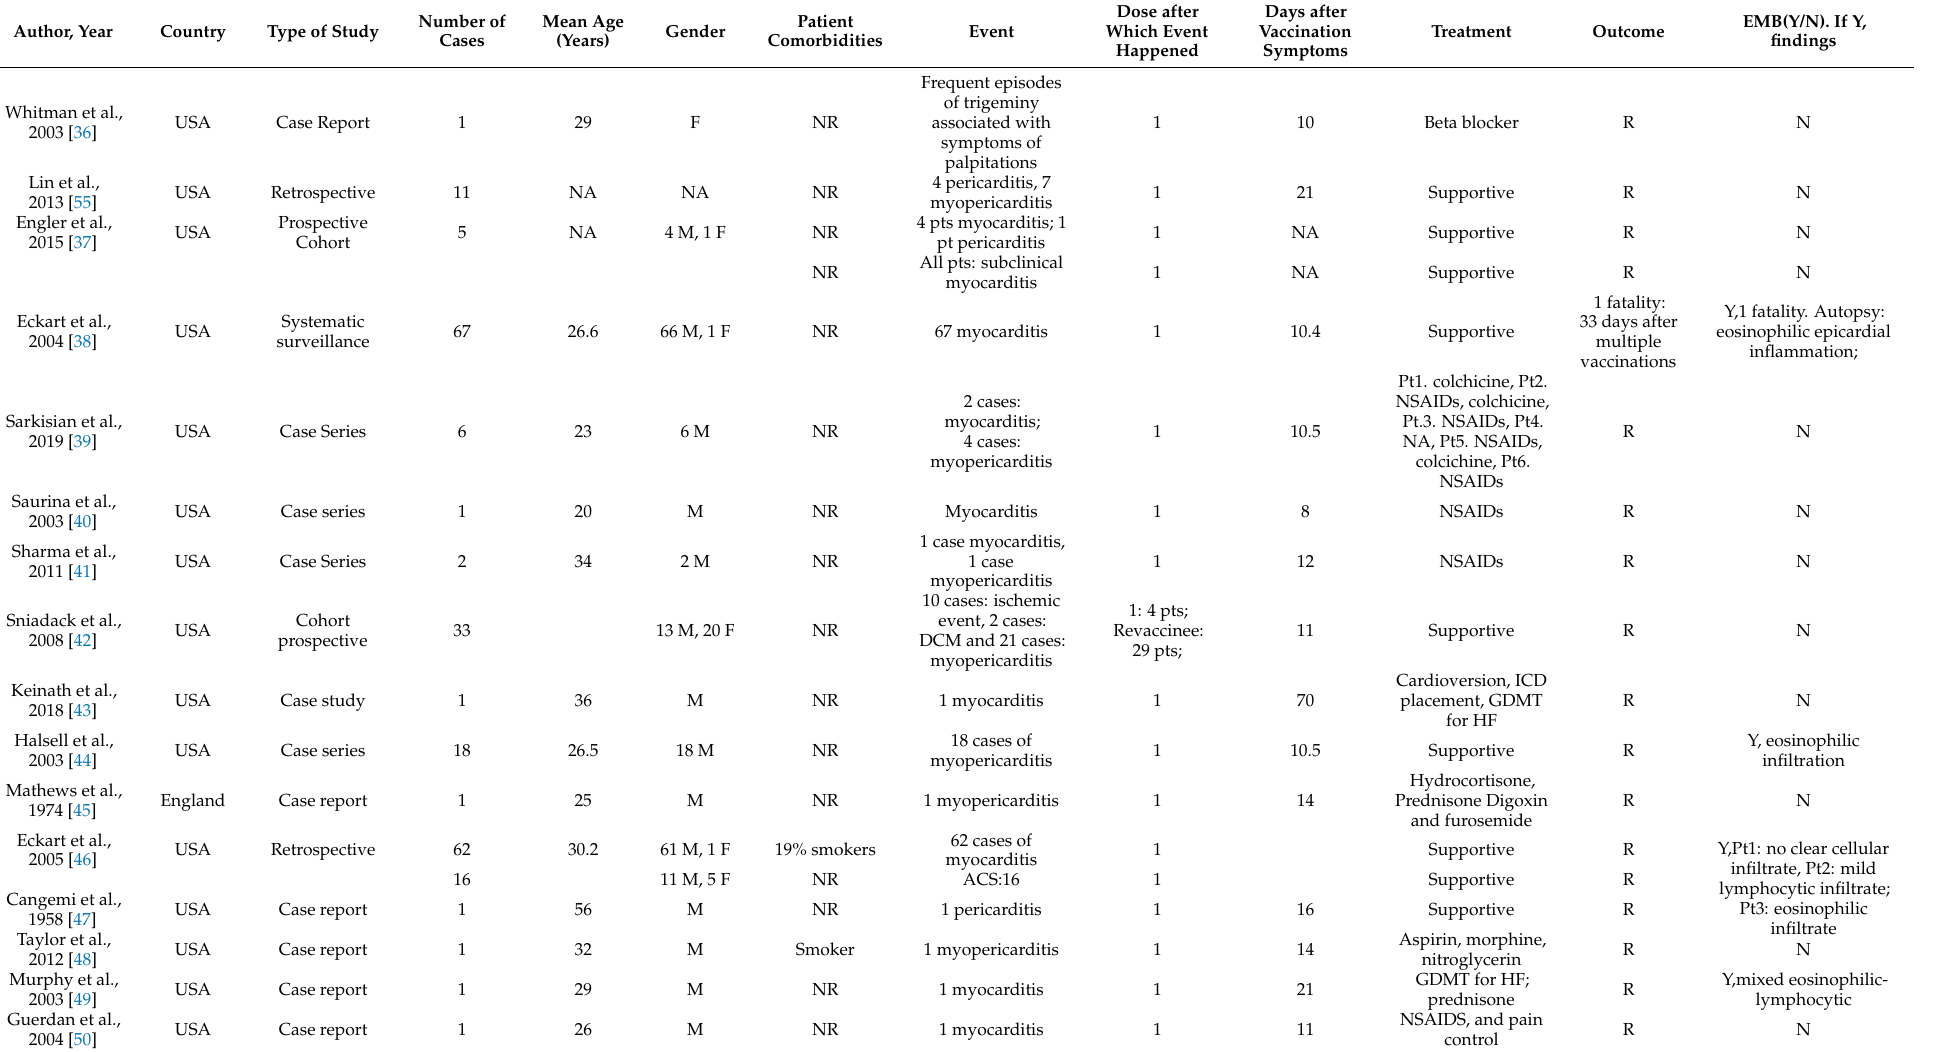
Table 4. Adverse events after Smallpox